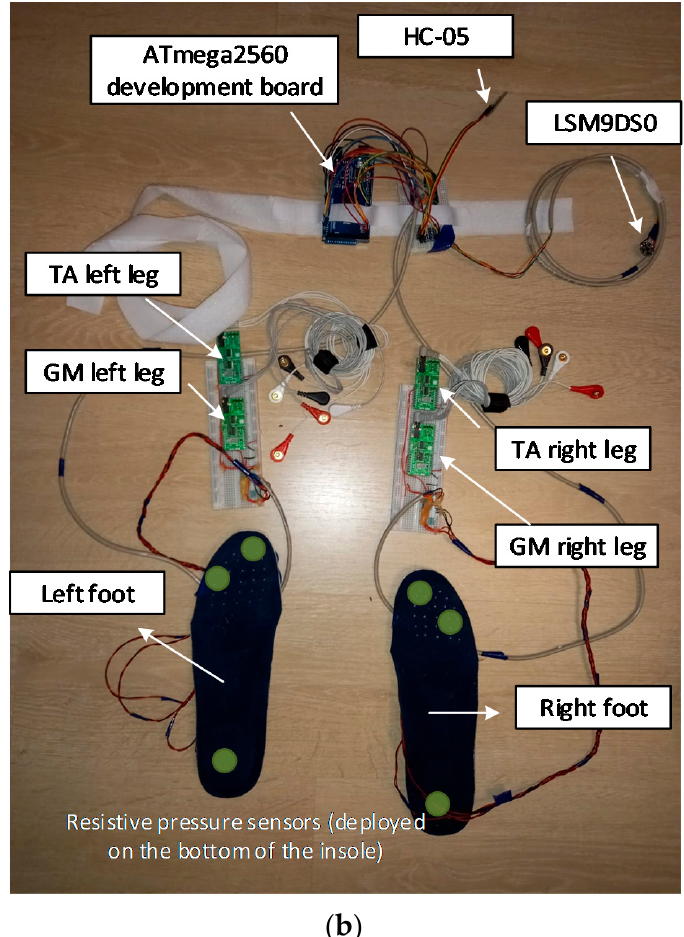
Figure 1. The proposed wearable physiograph for gait monitoring in PD: ( a ) block diagram and ( b ) practical realization.